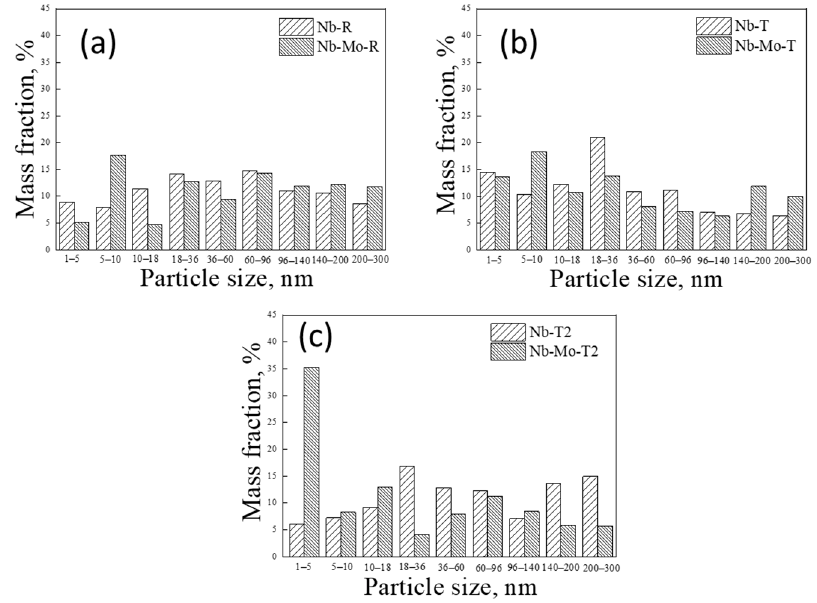
Figure 9. Size distribution of MC type precipitates in ( a ) rolled samples for Nb and NbMo steels and ( b ) Nb and Nb-Mo steels tempered at 600 °C for 15 min of, and ( c ) Nb and Nb-Mo steels tempered at 600 °C for 60 min, respectively.